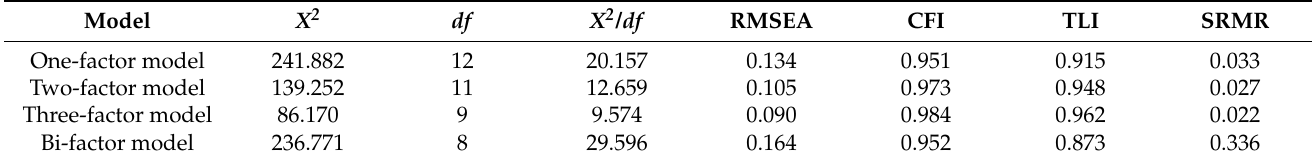
Table 2. Model fit indicators for different CFA models of the Self-Supporting Ability Scale.